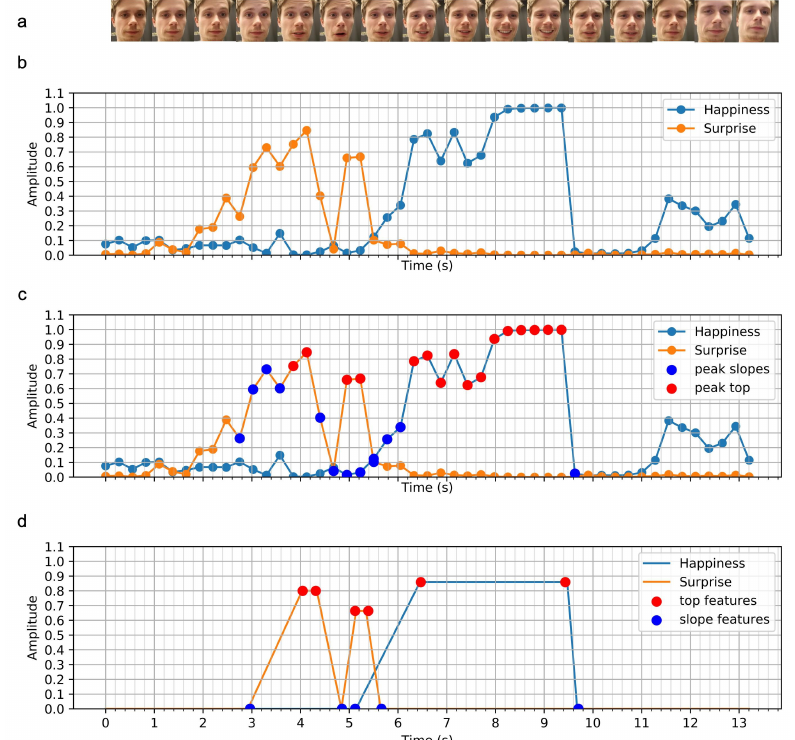
Figure 3. Raw signals to features pipeline: ( a ) frames after face detection, ( b ) prediction probabilities of happiness and surprise made by the neural network model ( c ) peak detection and characterization performed on the predictions ( d ) extracted peak